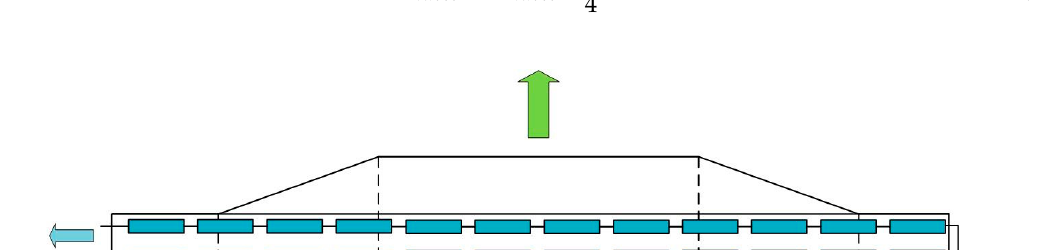
Figure 5. Kettle boiler side view and flow scheme.